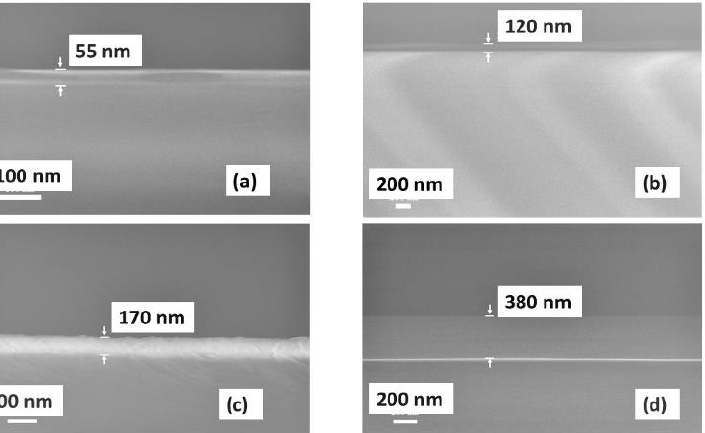
Figure 1. SEM cross-sectional images showing the thickness of YIG films deposited for ( a ) 30, ( b ) 60, ( c ) 90, and ( d ) 120 min on (100) YAG.